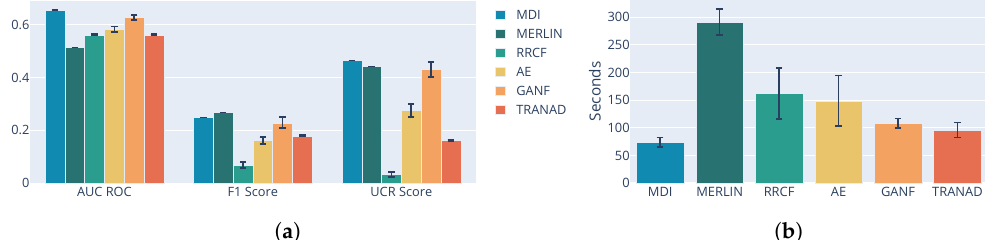
Figure 4. ( a ) Macro-averaged performance metrics for each method. The error bars indicate the standard deviation caused by random effects over six repetitions of the experiment. ( b ) Average runtime per time series. For the deep-learning methods, training time is included. The error bars indicate the standard deviation over six repetitions of the experiment. Table 2. Performance comparison of six anomaly detection methods on macro-averaged AUC ROC, F1 score, UCR score and runtime for a single time series. Results are grouped by model class (classical ML and deep learning) and presented as mean ± standard deviation over six repetitions. The value in each second column denotes the mean aggregated by method